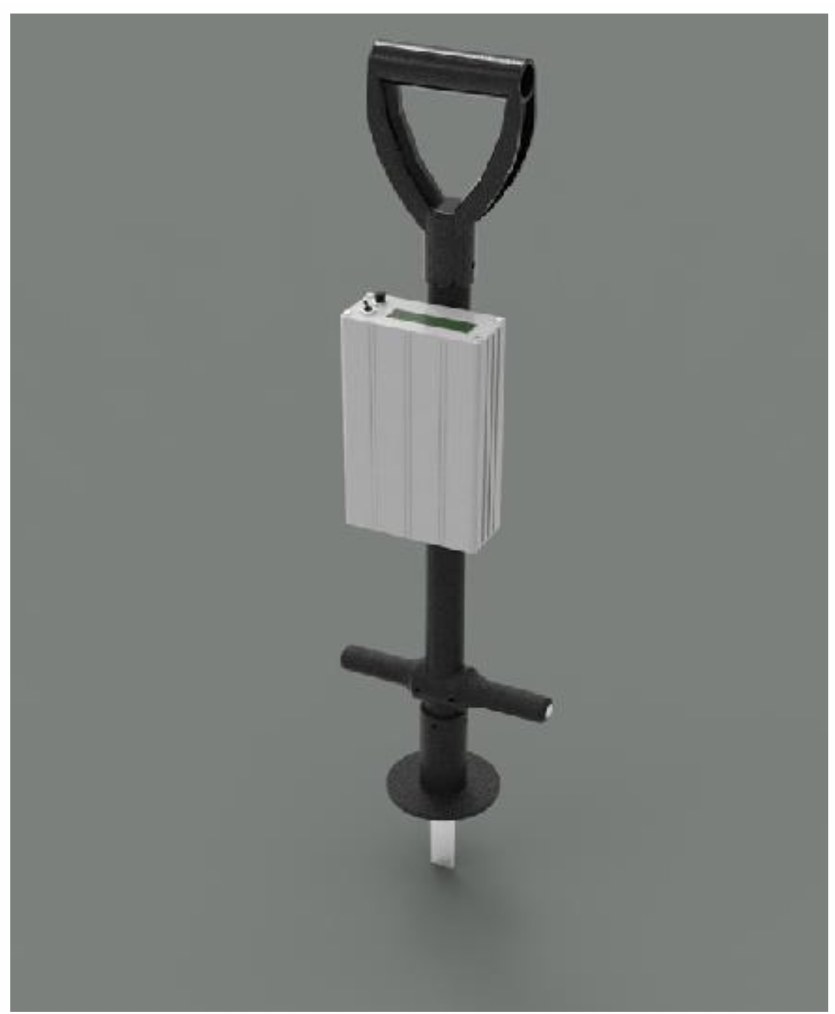
Figure 4. A drawing of the two axis commercial strain-gauge sensor, the Going